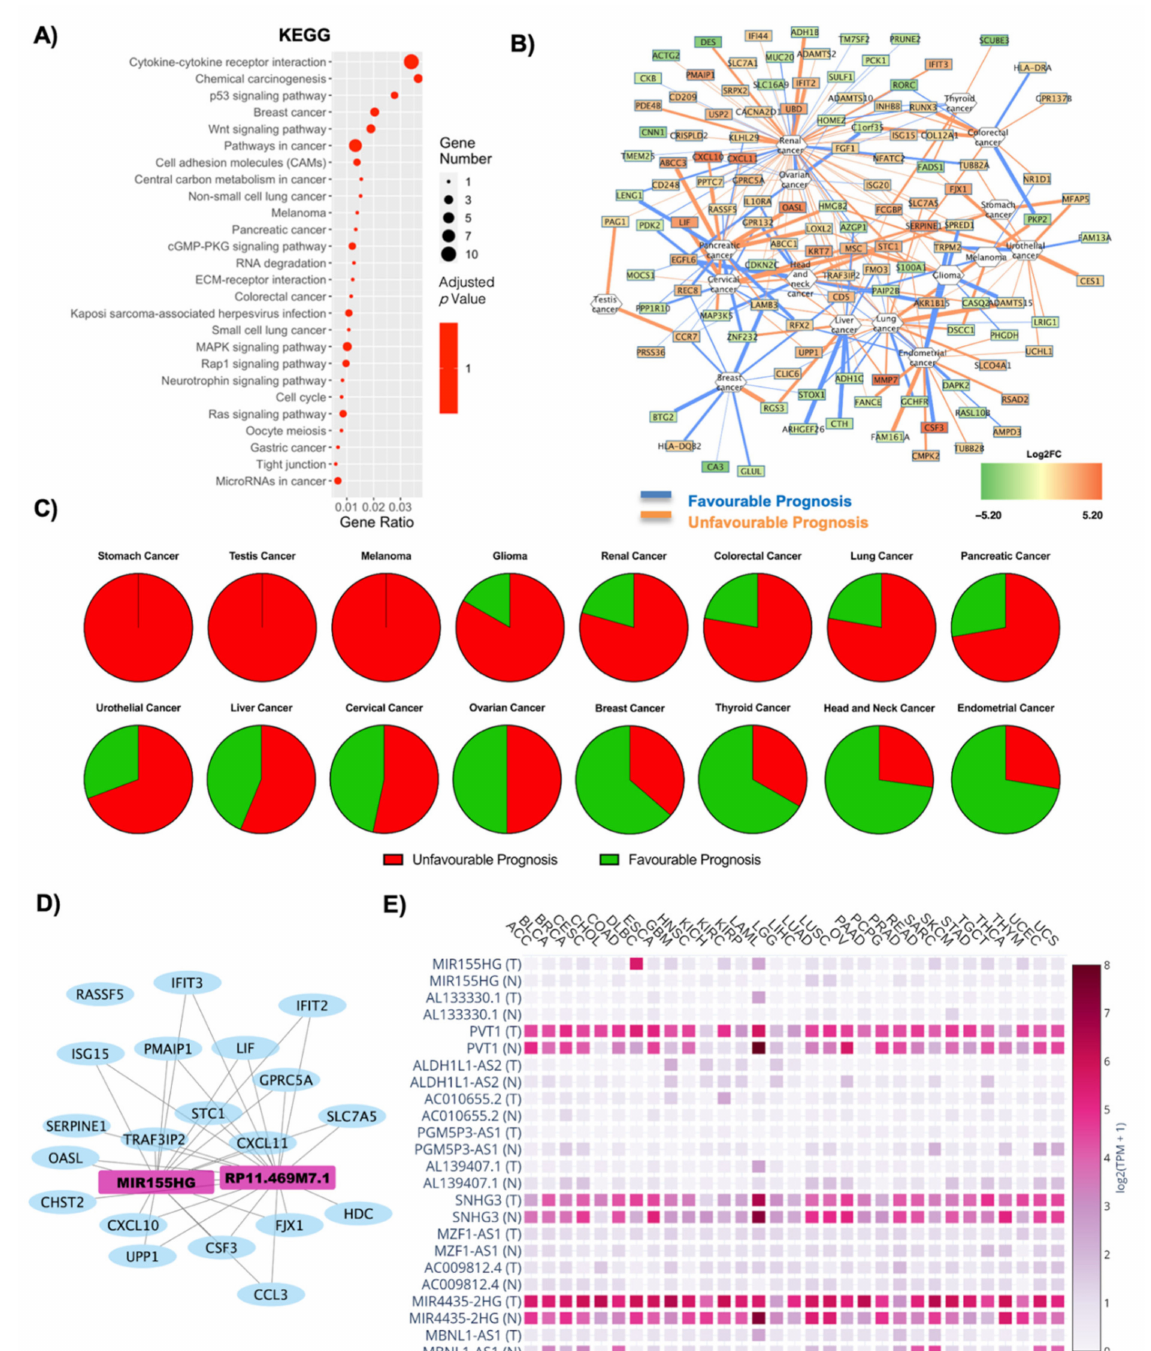
Figure 4. Cancer pathways and oncogene analysis in OBT2D vs. CTRL condition. ( A ) Dotplot of deregulated oncogenic pathways from KEGG analysis. The y-axis represents the name of the pathway, the x-axis represents the gene ratio, dot size represents the number of different genes and the color indicates the adjusted p -value. ( B ) Correlation network highlights the relationship between DE RNAs and the possibility of a cancer diagnosis. Nodes are DE RNAs and are ranked according to fold change whereas edges indicate disease prognosis and are colored according to favorable (light blue) and unfavorable (orange) prognosis. ( C ) Pie graph displays the overall unfavorable or favorable prognosis. ( D ) Co-interaction network between lncRNAs on OBT2D vs. CTRL and the oncogenes highlighted after OncoScore analysis. Light blue nodes are coding genes whereas pink nodes are lncRNAs. ( D ) The GEPIA2 database displays the specific annotated expression of each lncRNA in tumoral and normal